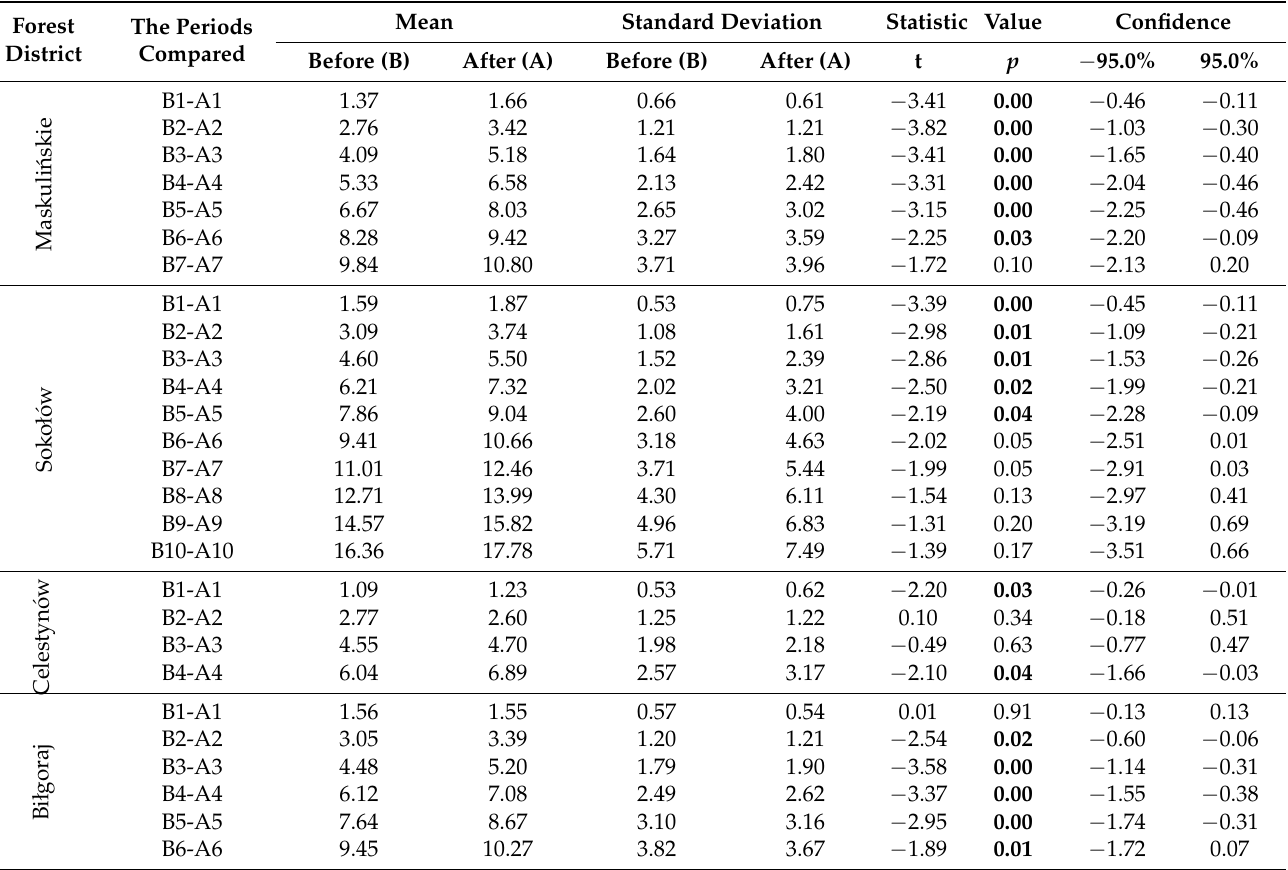
Table 3. Statistical significance ( p ) of Scots pine radial growth in the compared periods (Student’s t -test). Mean Standard Deviation Statistic Value Forest The Periods District Compared